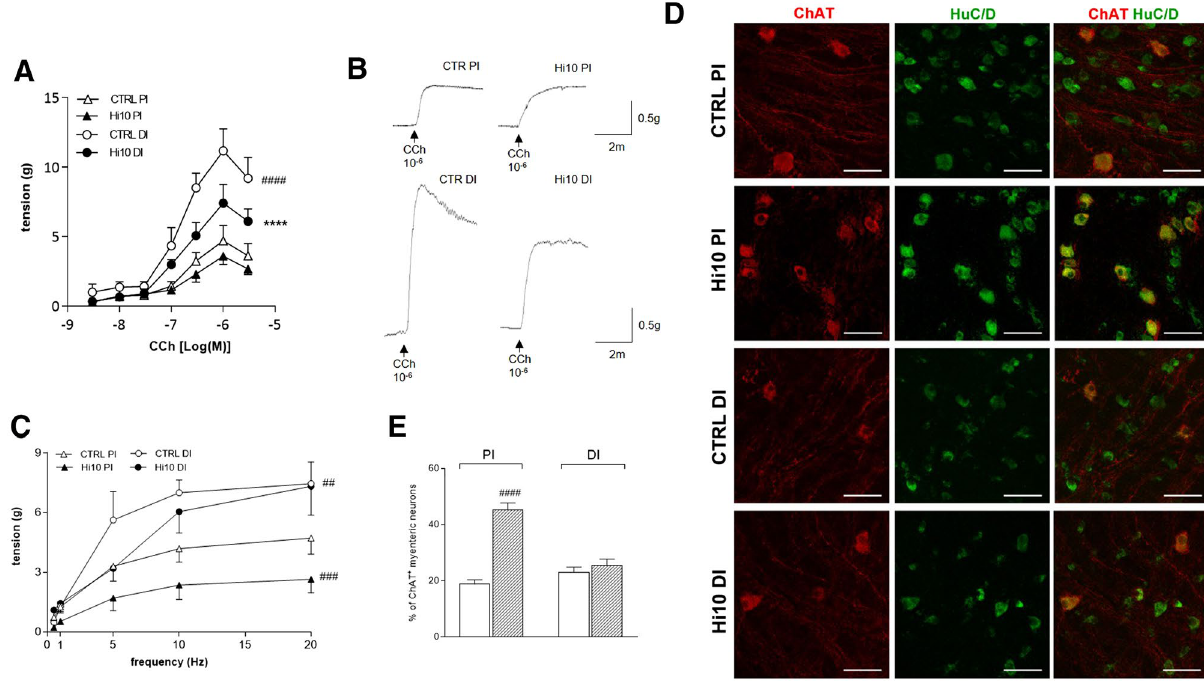
Figure 4. Hermetia illucens meal influences excitatory contractility in the proximal and distal intestine of the gilthead sea bream. ( A ) Concentration–response curves to carbachol (CCh) of isolated proximal (PI) and distal (DI) intestinal segments obtained from animals fed with a fishmeal standard diet (CTRL) and with a diet containing 10% Hermetia illucens (Hi10) meal. ( B ) Tracing displaying the excitatory effect of CCh 1 µM on basal tone of the proximal and distal gilthead sea bream obtained from CTRL and Hi10 animals. ( C ) Neuromuscular excitatory responses induced by EFS (0.5–20 Hz) in isolated proximal and distal intestine preparations obtained from the different experimental groups. N = 5 fish/group. ( D ) Representative confocal photomicrographs showing the distribution of ChAT (red, marker for cholinergic neurons) and HuC/D (green, pan-neuronal marker) in the different experimental groups. Bars: 50 μm ( E ) percentage of ChAT + myenteric neurons in LMMP preparations of the proximal (PI) and distal intestine (DI) obtained from CTRL (empty bars) and Hi10- fed (slashed bars) (N = 5 fish/group). Data are reported as mean ± SEM with N = 5 fish/group. ( A , B ) statistical significance: **** P < 0.0001 versus CTRL DI; #### P < 0.0001; ### P < 0,001, ## P < 0.01 versus CTRL PI by Two-way